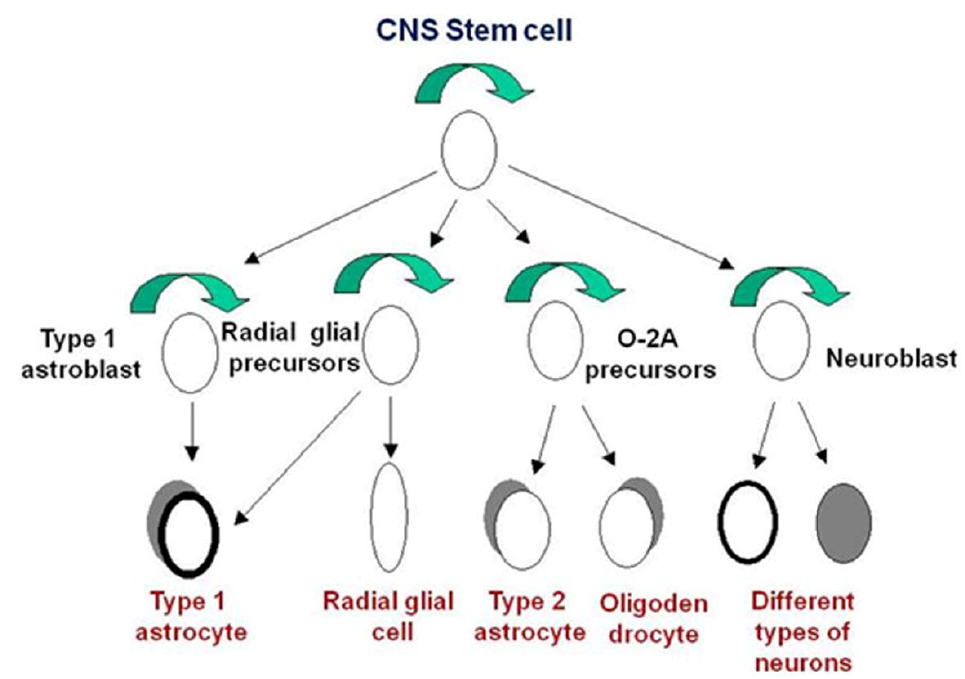
Figure 1. A diagram showing the relationships between the major central nervous system (CNS); cell types Self-